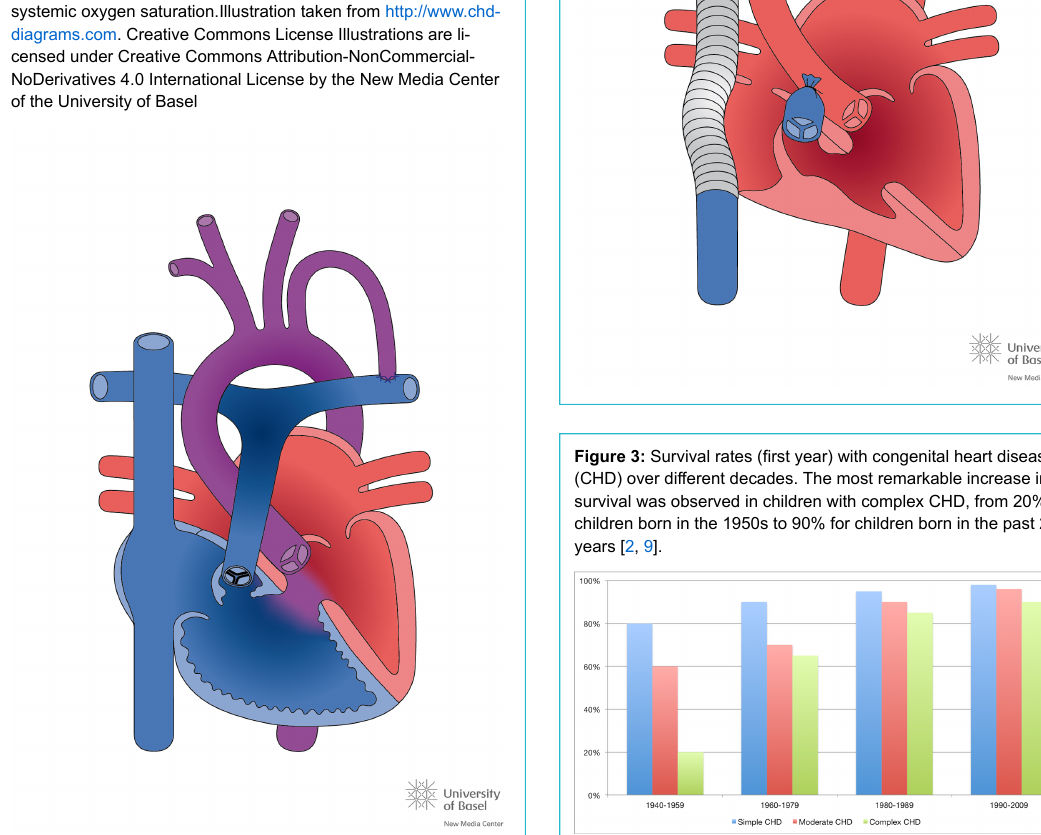
Figure 1: Blalock-Taussig-Shunt . Classic Blalock-Taussig shunt for palliation of cyanotic heart disease due to reduced pulmonary blood flow. The subclavian artery is sacrificed and increases blood flow in the corresponding pulmonary artery, thereby increasing systemic oxygen saturation.Illustration taken from http://www.chd- diagrams.com. Creative Commons License Illustrations are li-